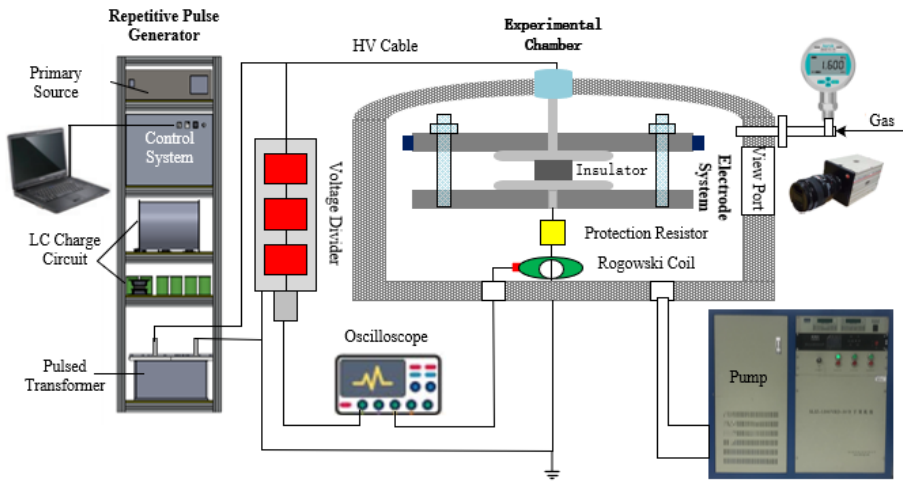
Figure 2. The schematic diagram of the experimental setup.